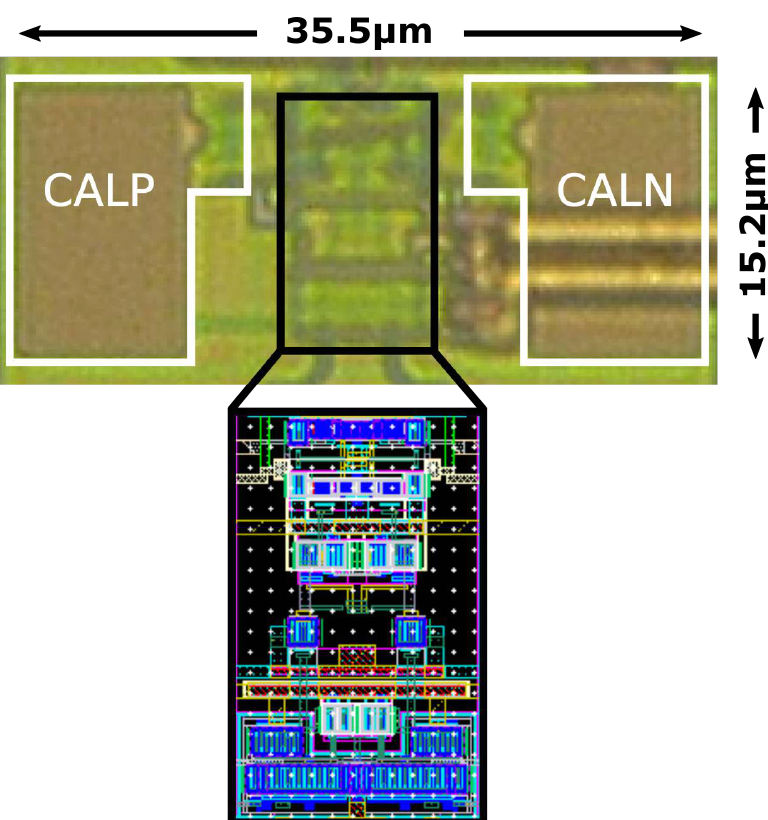
Figure 8. Die photo of the 28nm self-calibrating comparator with a layout view of the comparator core.